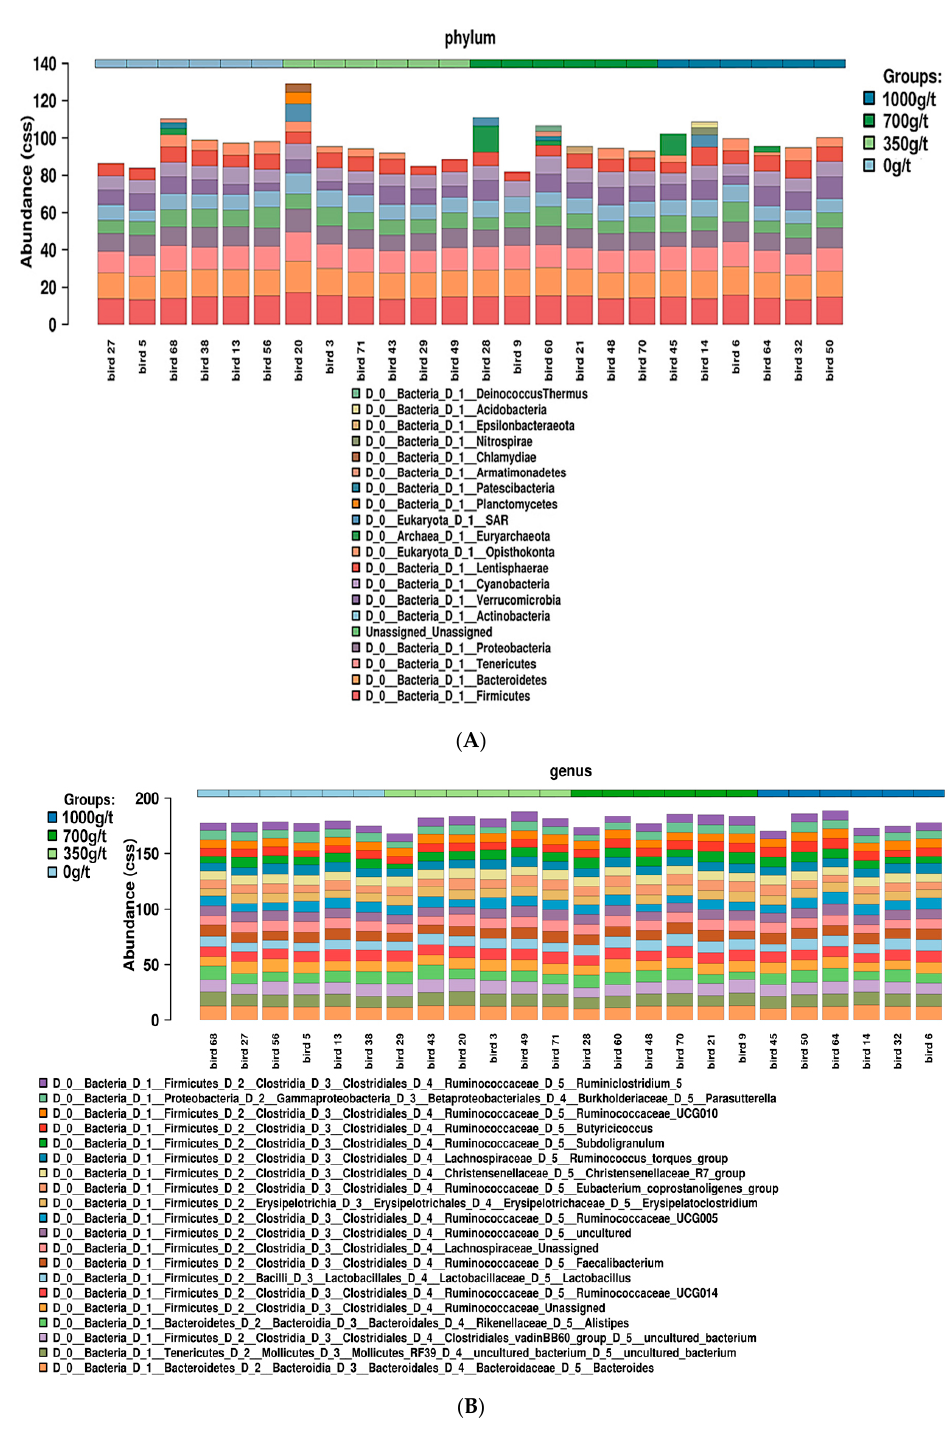
Figure 3. ( A ) Relative abundance of operational taxonomic units (OTUs) present in each poultry digesta sample, at a phylum level. ( B ) Relative abundance of OTUs present in each poultry digesta sample, at a genus level.